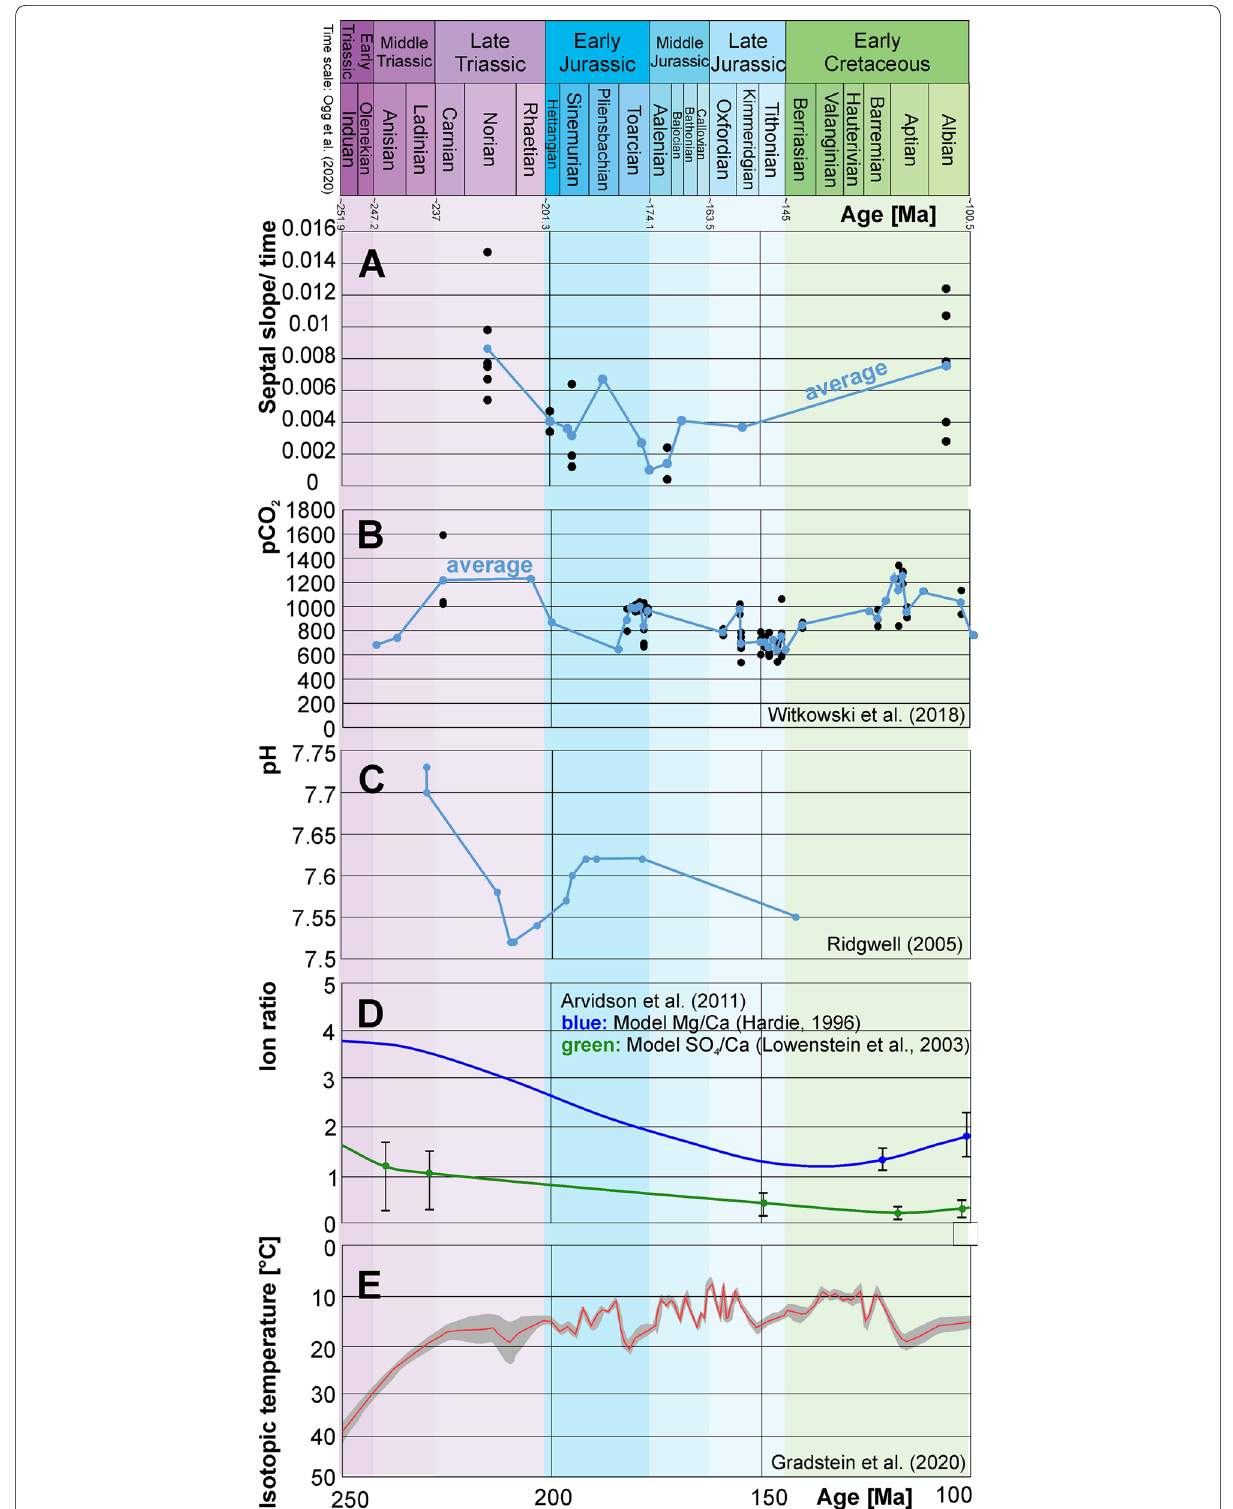
Fig. 10 Correlation of abiotic factors, time scale after Cohen et al. (2013). A septal slope factor versus time (blue line: the average); B atmospheric CO 2 (Witkowski et al., 2018). C isotopic temperature after Veizer and Prokoph (2015. D Ion ratios of Mg/Ca and SO 4 /Ca after Arvidson et al.